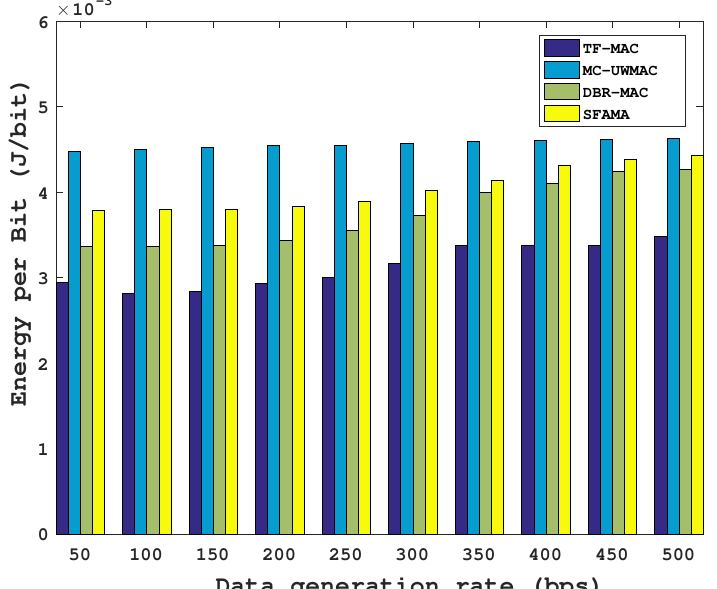
Figure 17. Comparison of energy consumption per bit in the sparse